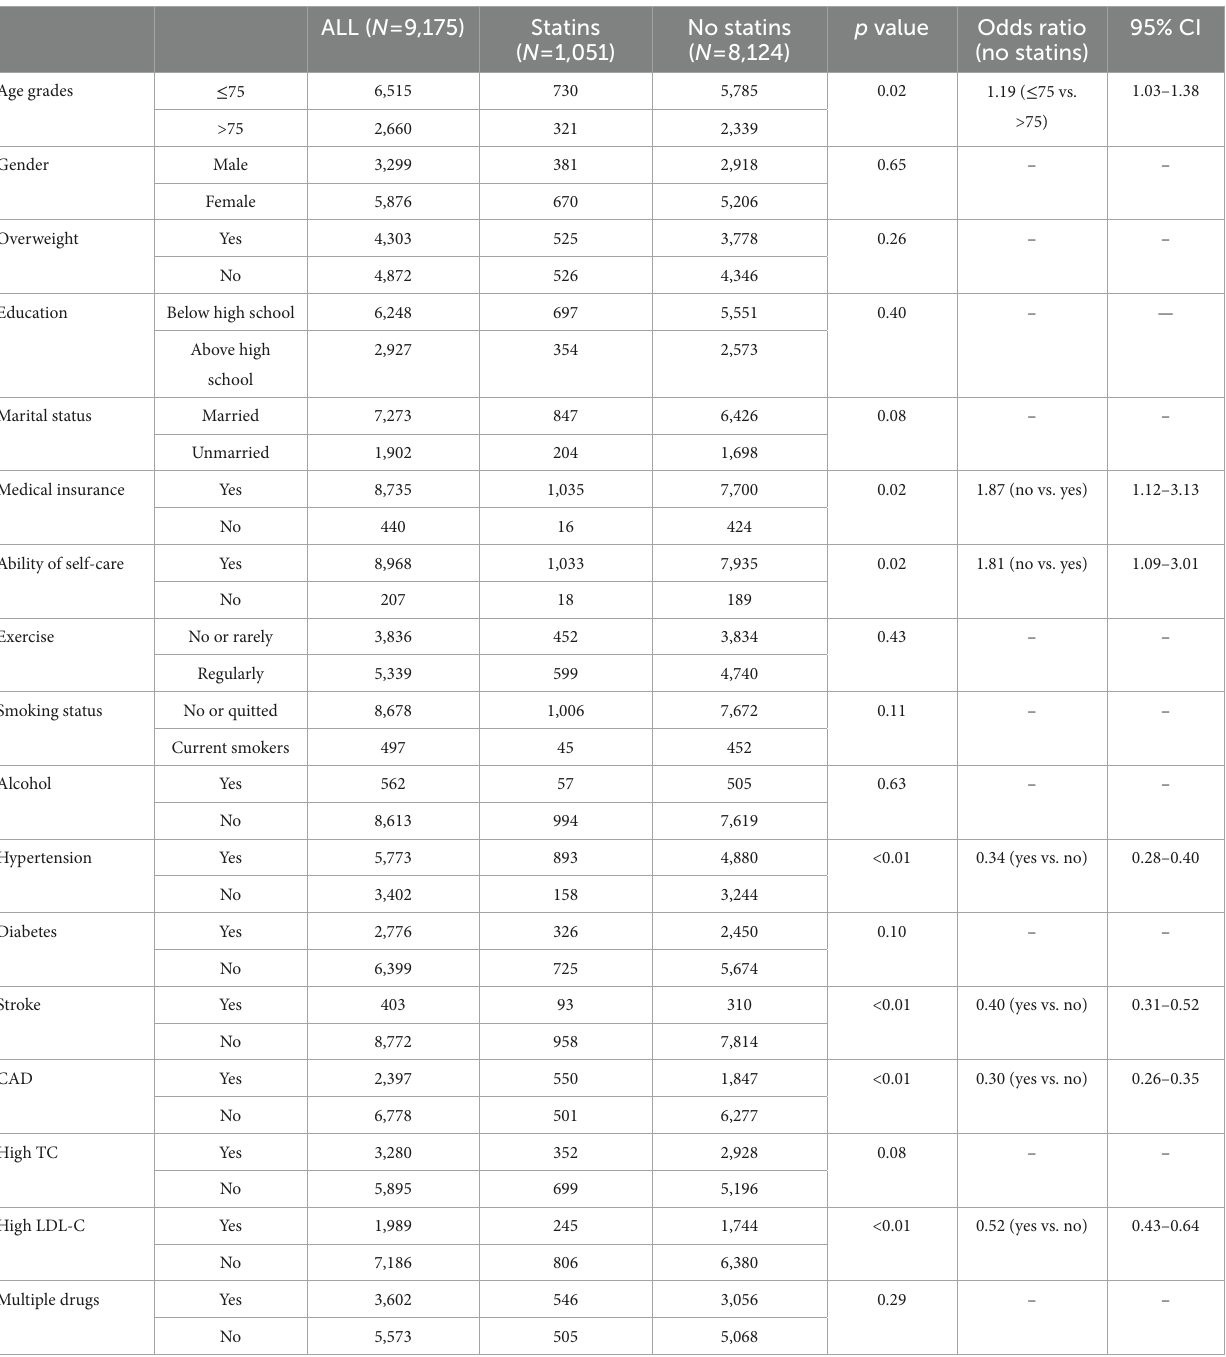
TABLE 3 Clinical factors associated with statins use in older